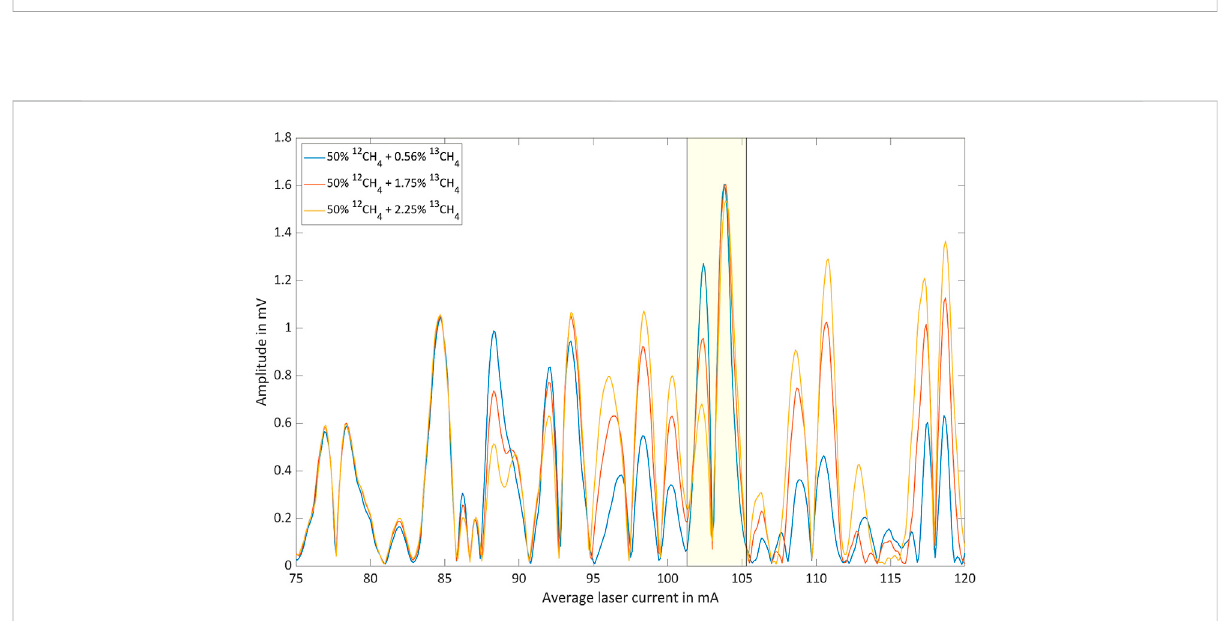
FIGURE 7 Photoacoustic signal as function of the average laser current for 50% 12 CH 4 with three different 13 CH 4 shares in